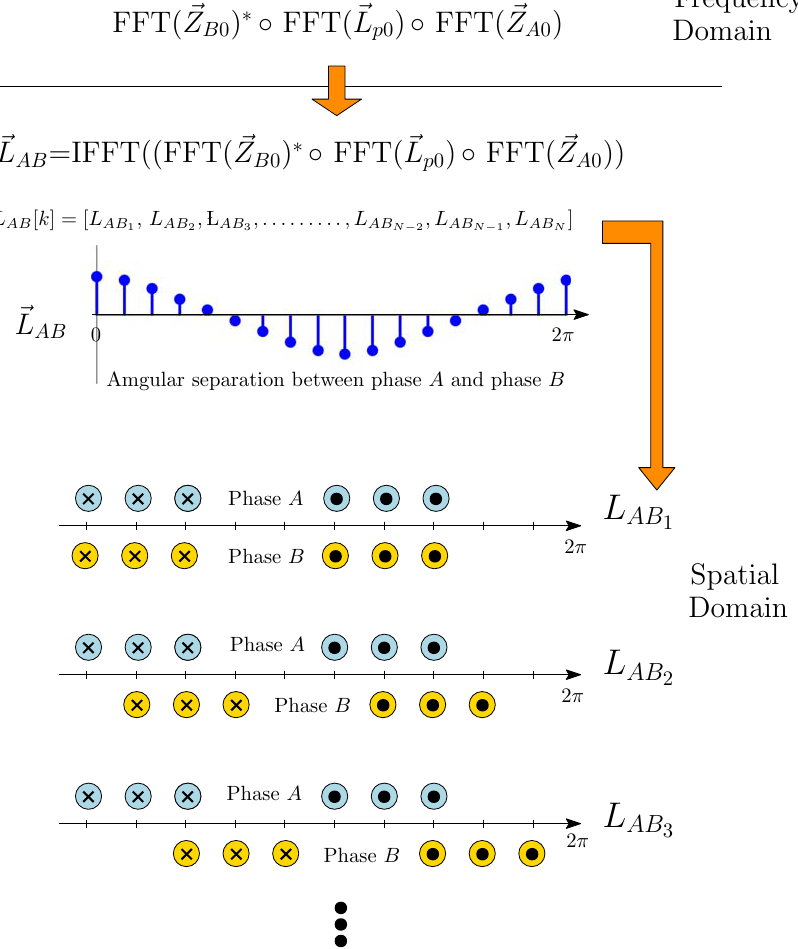
Figure 6. Block diagram for the computation of the mutual inductance between phases A and B with (50). ( a ) Construction of the vectors with the layout of the conductors of phases A , (cid:126) Z A , and B , (cid:126) Z B , and the partial inductance between a conductor placed at the origin and other conductor at successive positions, (cid:126) L p 0 ; ( b ) Element-wise multiplication in the frequency domain of these three vectors; ( c ) Conversion into the spatial domain of the result of the multiplication, which gives the vector (cid:126) L AB . The element k of this vector, L AB [ k ] , is the mutual inductance between phases A and B for a relative angular position between them of k × 2 π / N